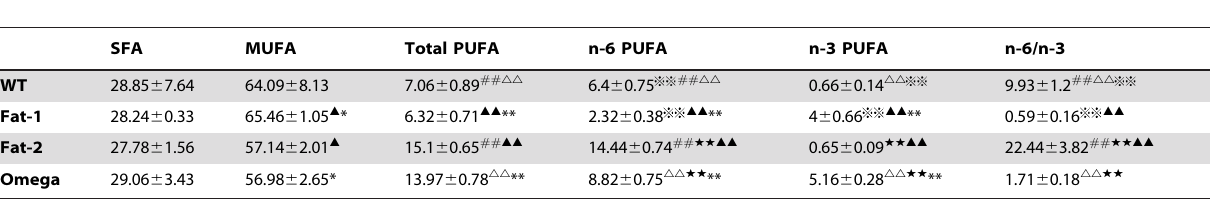
Table 2. Fatty acid profile of tail tissue from mice fed with a high-carbohydrate, no-fat diet.